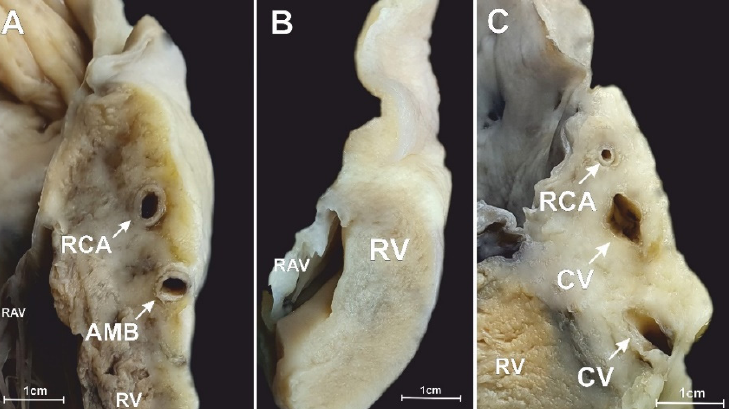
Figure 3. Photographs of a cadaveric heart specimen showing the longitudinal section through the middle right atrial appendage isthmus. ( A ) The right coronary artery (RCA) with acute marginal branch (AMB) is present. ( B ) Case with no coronary vessels present within the isthmus section. ( C ) RCA accompanied by two coronary veins (CV). RAV—right atrio-ventricular valve, RV—right ventricle.